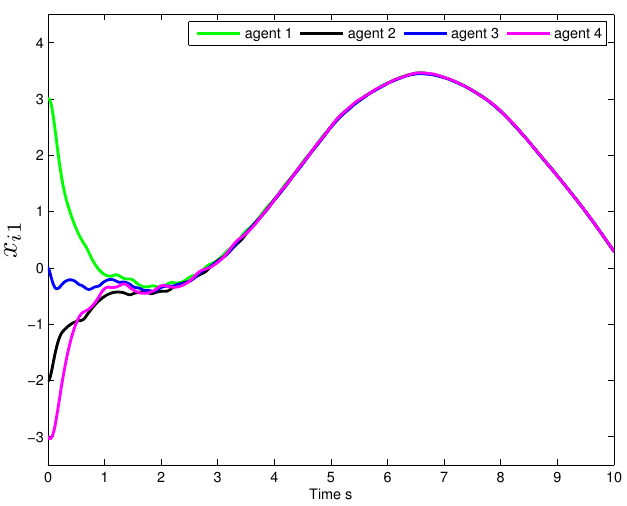
Figure 2. x i 1 ( t ) trajectories of MAS (42) with state-based algorithm.